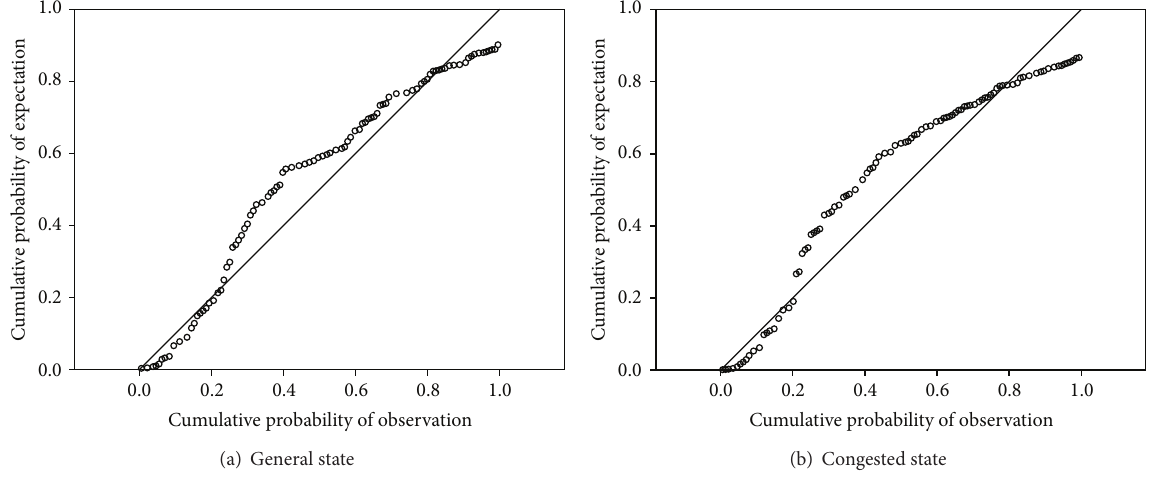
Figure 8: P-P figure of log-normal distribution fitting.